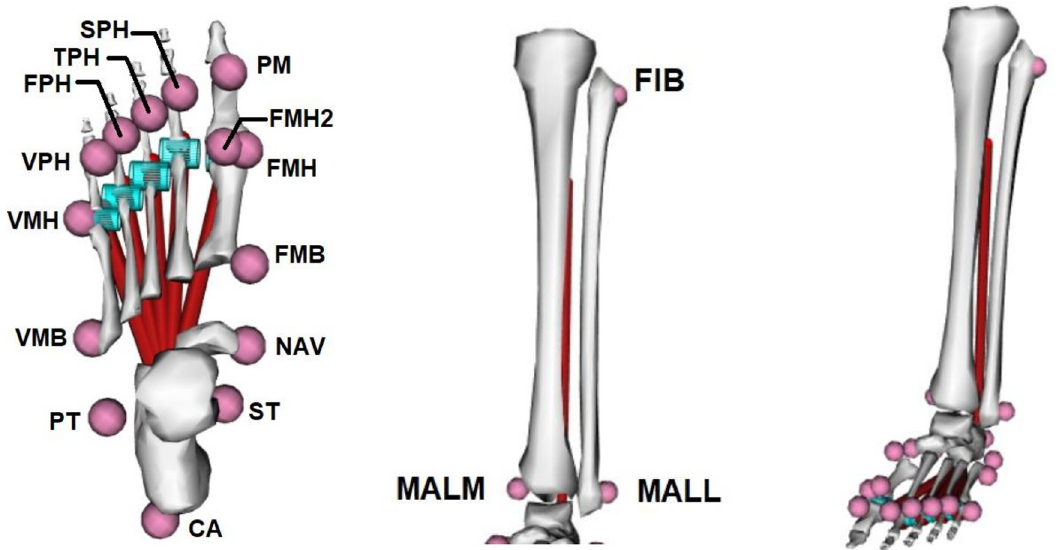
Fig 1. Foot model and marker positions. CA = calcaneus, ST = sustentaculum tali, PT = peorenal tubercle, NAV = navicularis, FMH, FMH2 and VMH = first and fifth metatarsal head, FMB and VMB = first and fifth metatarsal base, PM = head of the proximal phalanx of the 1st toe, SPH = head of the proximal phalanx of the 2nd toe, TPH = head of the proximal phalanx of the 3rd toe, FPH = head of the proximal phalanx of the 4th toe, VPH = head of the proximal phalanx of the 5th toe, MALM = medial malleolus, MALL = lateral malleolus, FIB =